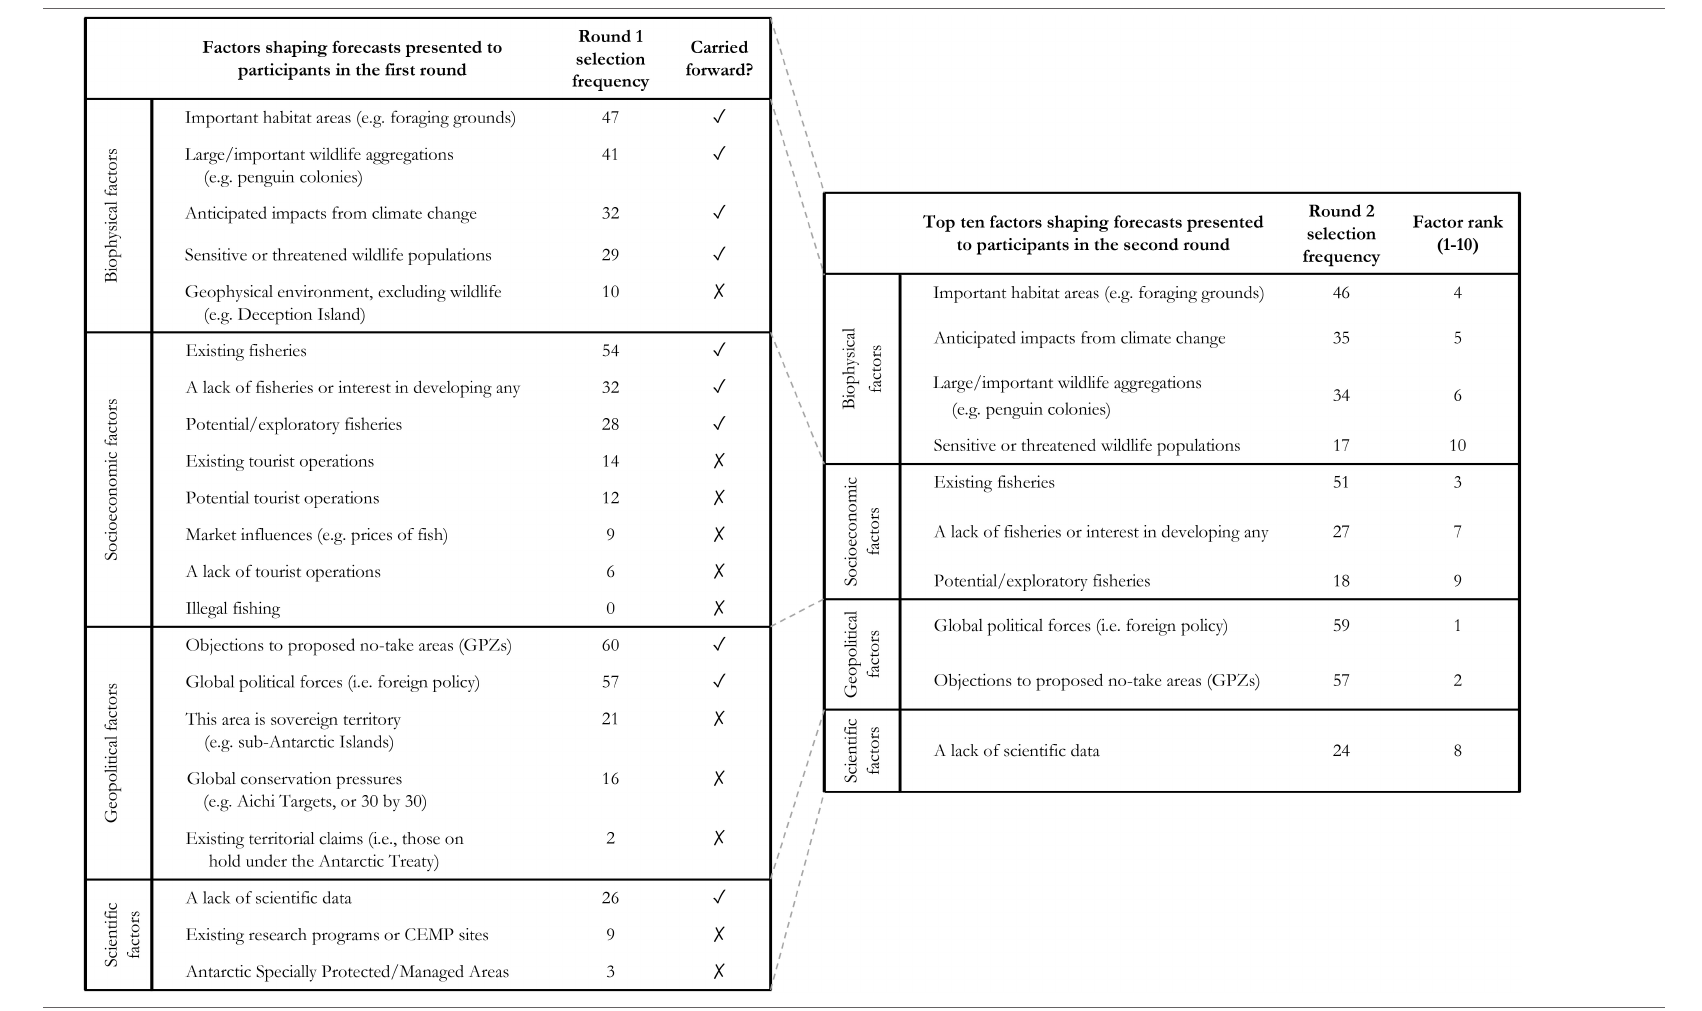
TABLE 1 | First round selection frequency of factors influencing quantitative forecasts – The factors below were presented to experts based on prior research (Sykora-Bodie and Morrison, 2019; Sykora-Bodie et al., 2021).